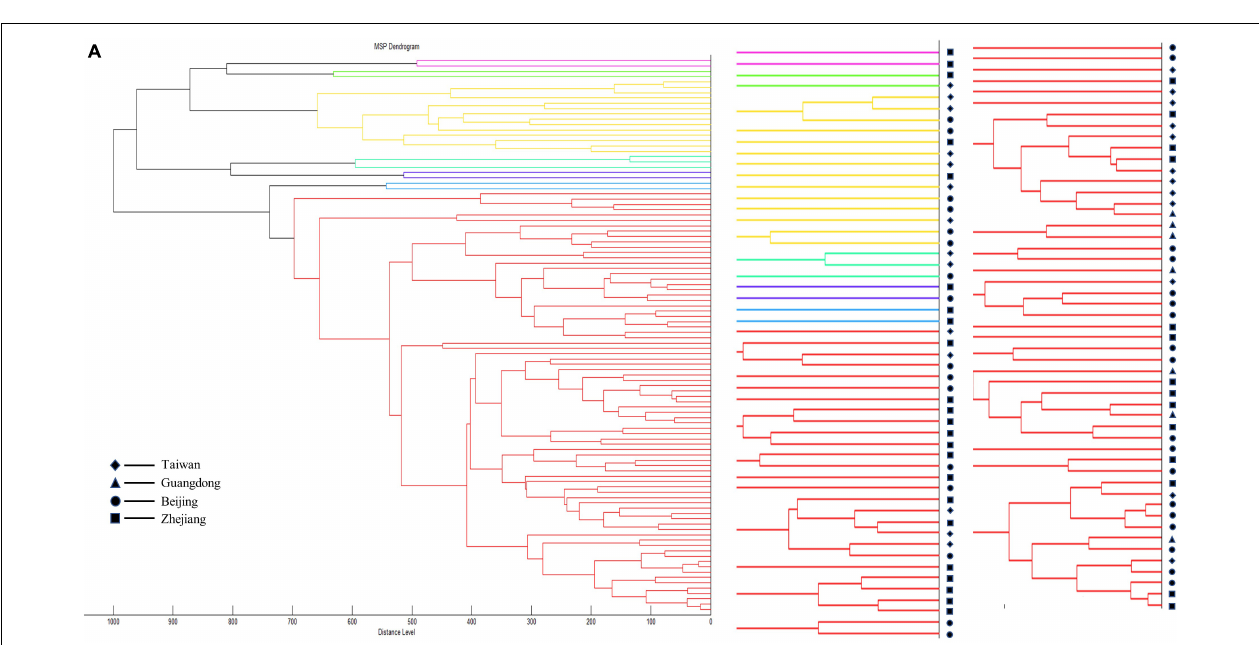
FIGURE 6 | CCI matrix of different Vibrio species. 77 strains of all Vibrio species were randomly selected from PVBase, which were consistent with the 77 strains selected for dendrogram analysis. A CCI analysis was performed using ClinPro Tools